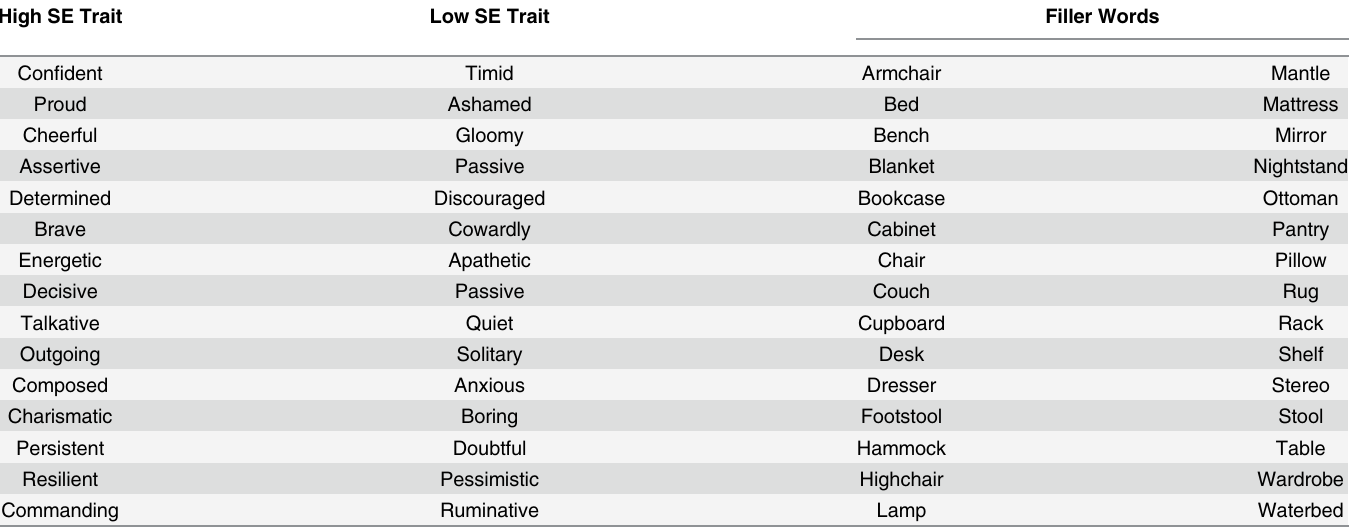
Table 1. List of word cues used in the